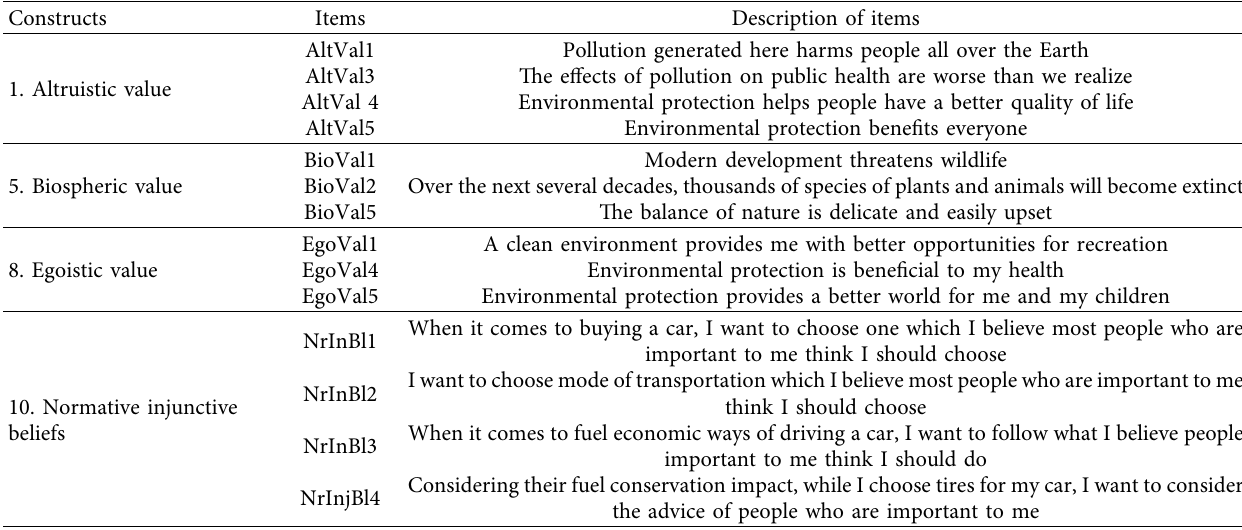
Figure 1: Extended model of theory of planned behaviour. Table 1: Description of the measurement instrument a